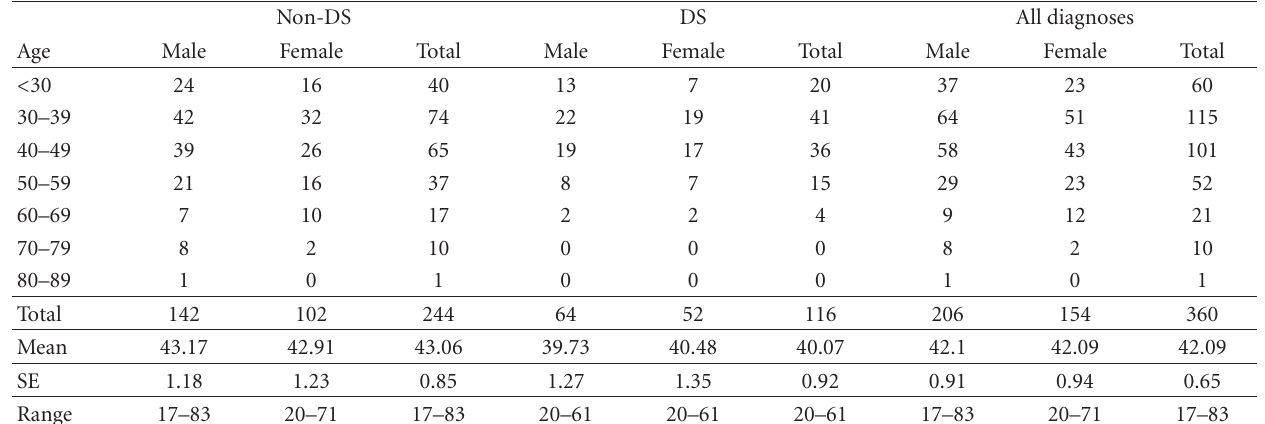
Table 1: Demographics of participants at entry to the study.